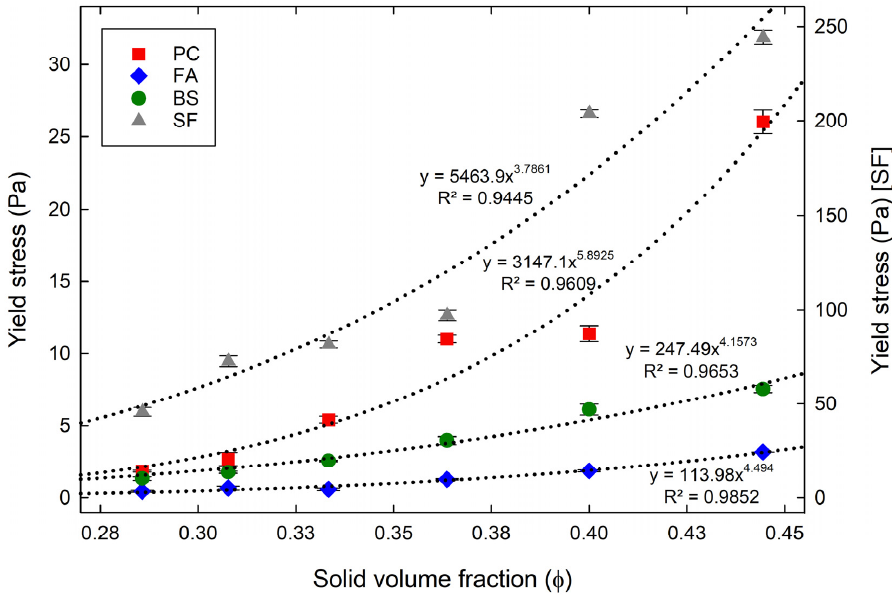
Figure 4. Yield stress of cementitious suspensions with different 𝜙 in the experiments.